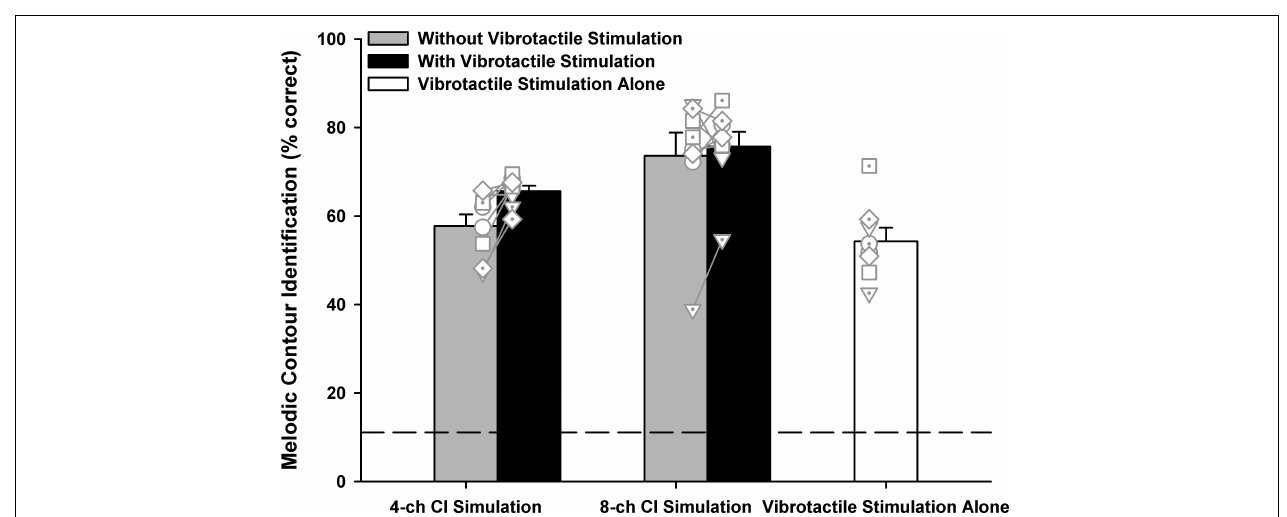
FIGURE 3 | Vibration discrimination performance as a function of the vibration frequency interval (on the bottom axis) or vibration amplitude difference (on the top axis). Symbols represent the mean, while error bars represent the standard error across participants. The horizontal dashed line indicates the chance performance of 50% correct.